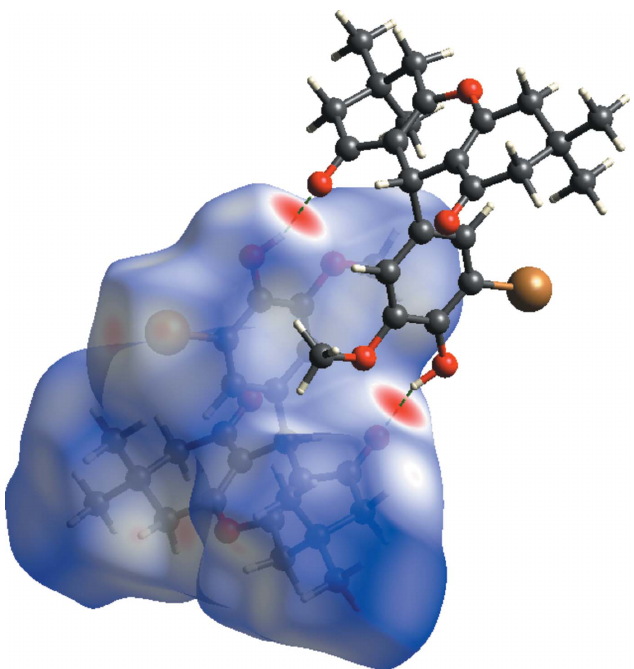
Figure 4 View of the three-dimensional Hirshfeld surface of (I) plotted over d norm in the range (cid:5) 0.5451 to 1.6834 a.u. The two O—H (cid:3)(cid:3)(cid:3) O hydrogen bonds forming the dimer are depicted as dashed lines.